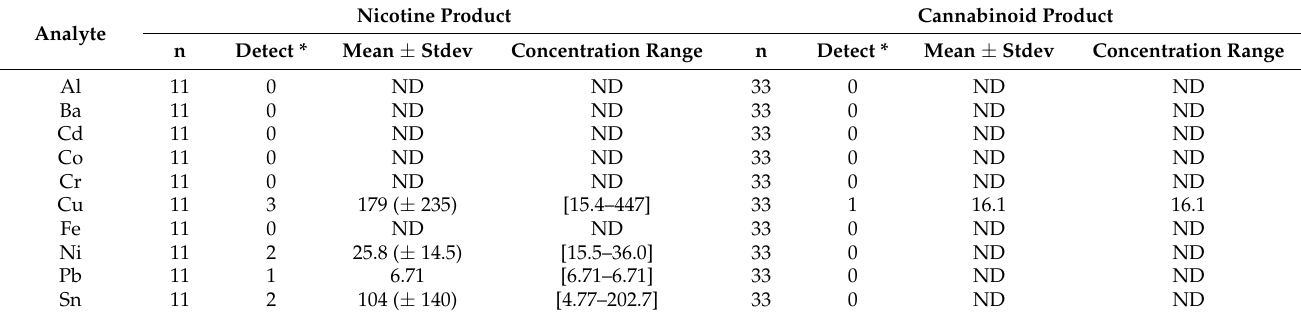
Table 6. Product categorization of the samples by their cannabinoid and nicotine content with concentration range in ng/10 puffs. Analyte